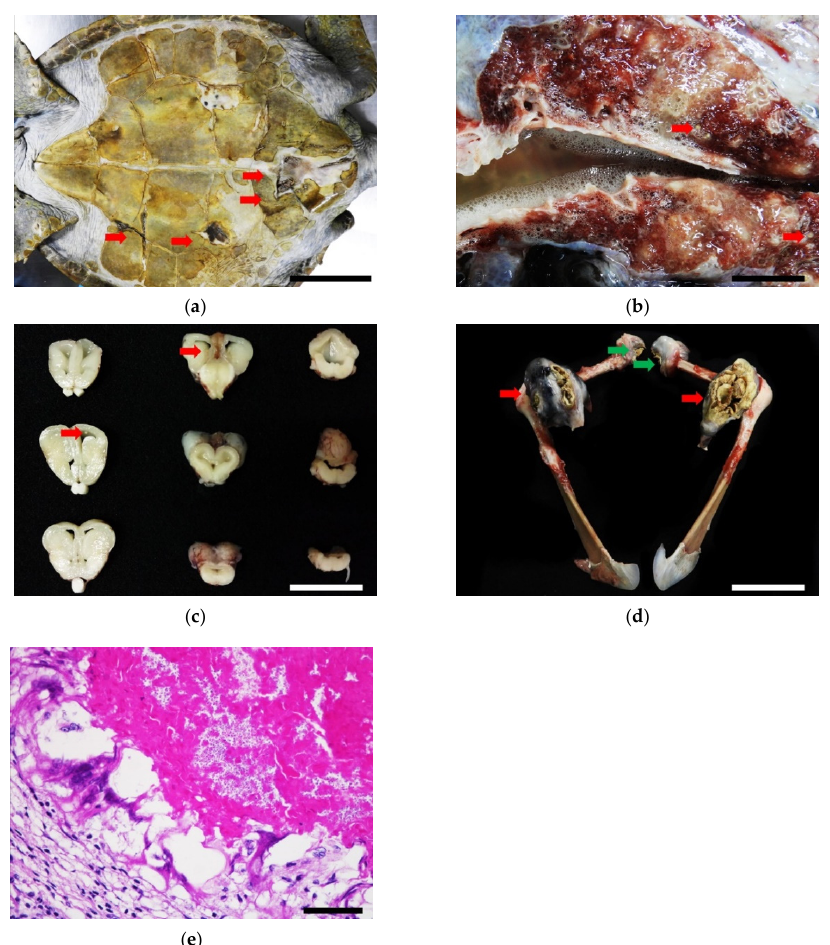
Figure 6. ( a ) Four irregular- and variably-sized puncture wounds were observed on the gular, humeral, pectoral, and femoral scutes of the plastron (red arrows). Scale bar = 15 cm. ( b ) Multiple, 0.2 × 0.2 × 0.2 cm, irregular, beige to yellowish nodules were noted on the cut sections of lungs (red arrows). Scale bar = 2 cm. ( c ) The same nodules were noted on serial sections of the brain (red arrows). Scale bar = 2.5 cm. ( d ) Both acromion processes were deformed and replaced by approx- imately 8 × 5 × 5 cm encapsulated masses consisting of fragile caseous materials (red arrows). The articular surfaces of both humeroradial joints were rough with caseous materials (green arrows). Scale bar = 10 cm. ( e ) In the neuroparenchyma, necrogranulomas containing numerous round-to-oval, 2 to 4 μ m-diameter, pale-staining, thin-walled yeasts were noted. Hematoxylin and eosin stain. Scale bar = 50 μ m.